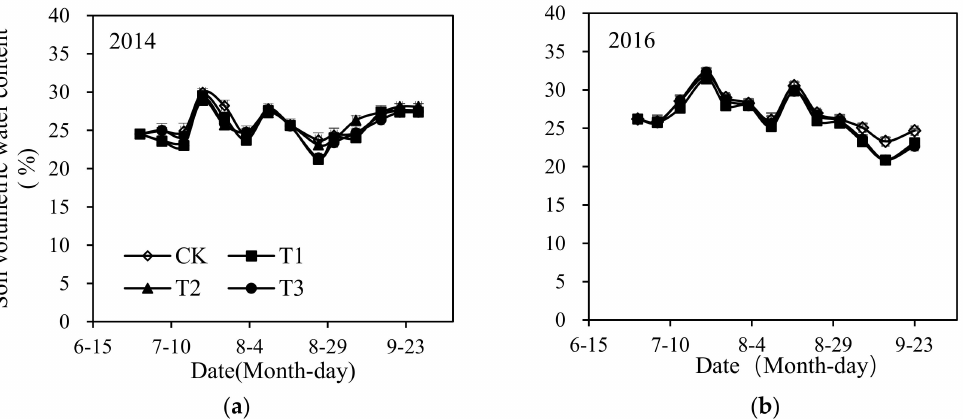
Figure 4. Mean soil volumetric water content (V/V, 0–40 cm) during the whole growth seasons of maize plants in 2014 ( a ) and in 2016 ( b ). CK, T1, T2, and T3 denote the control, nocturnal warming during the whole growth season, and nocturnal warming during the vegetative and reproductive stages,